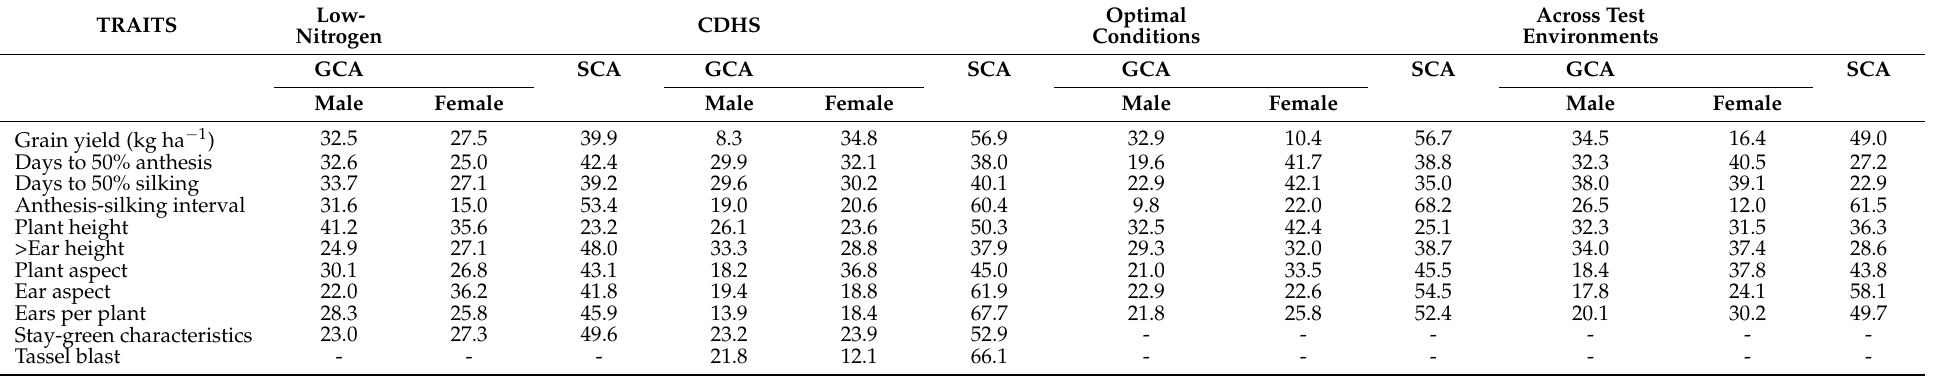
Table 3. Proportion of the sums of squares attributable to general combining ability (GCA) and specific combining ability (SCA) for grain yield and other agronomic traits of early QPM inbred lines under low-nitrogen, CDHS, optimal and across test